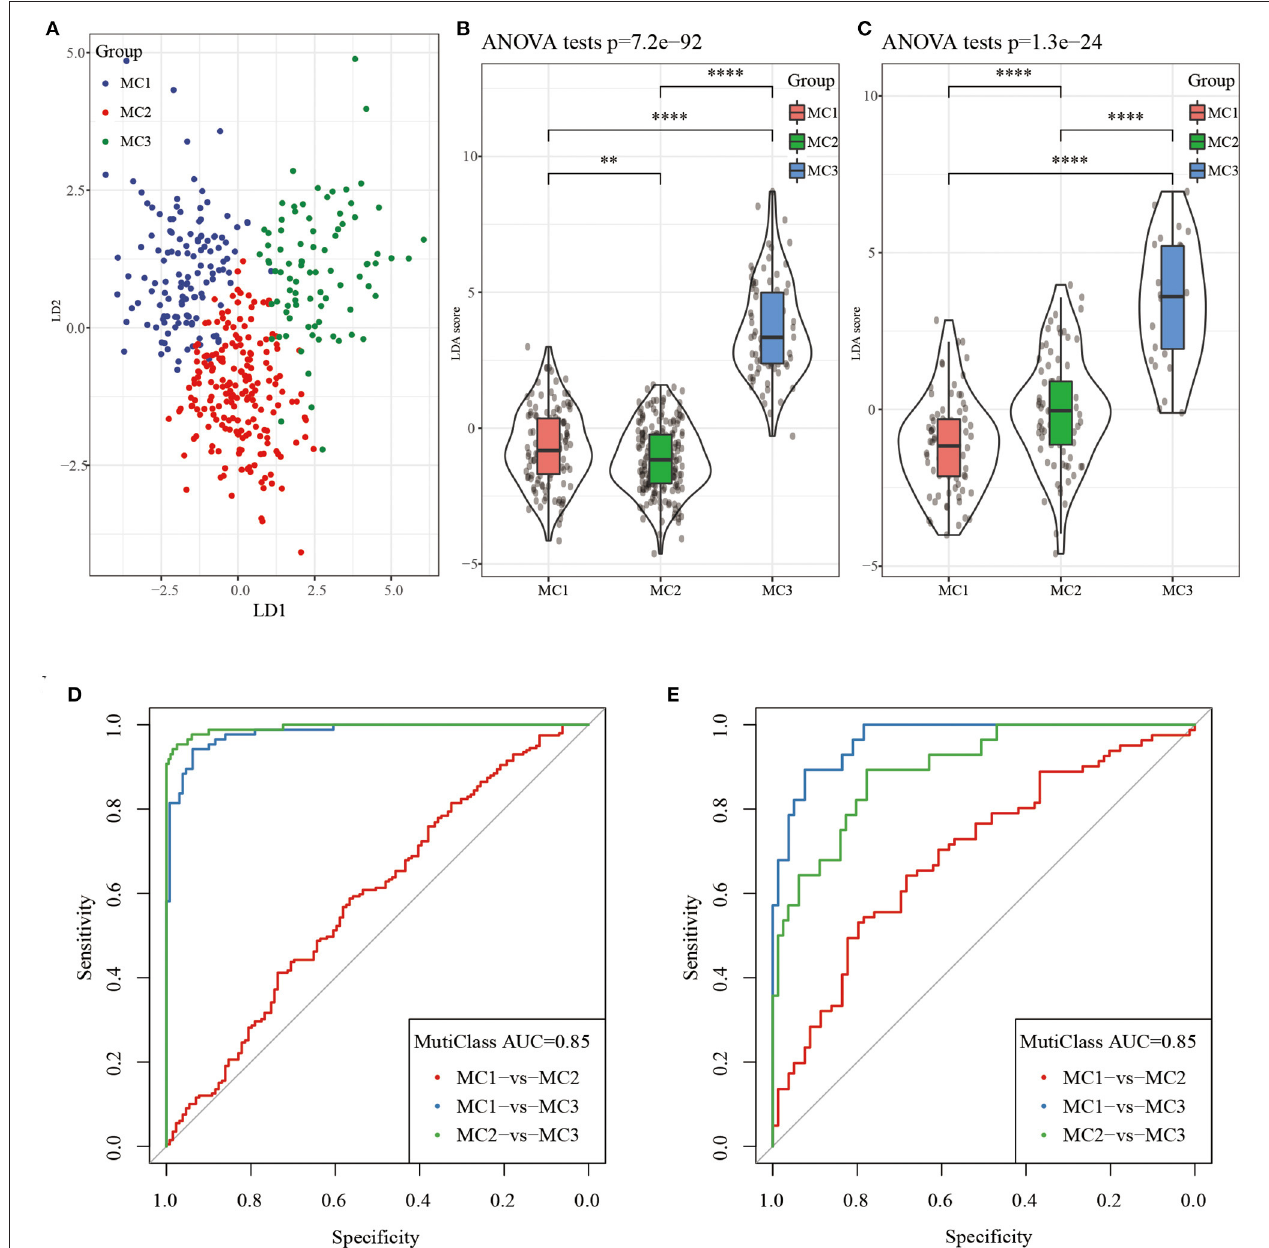
FIGURE 8 | (A) The relationship between the first two features in the RNASeq metabolic feature index and the metabolic subtypes, (B) The difference in the metabolic feature index of different subtypes in the RNASeq dataset; (C) The difference in the metabolic feature index of different subtypes in the GSE dataset; (D) ROC curve of metabolic feature index in RNASeq dataset; (E) ROC curve of metabolic feature index in GSE dataset. ** P < 0.01, **** P < 0.0001.